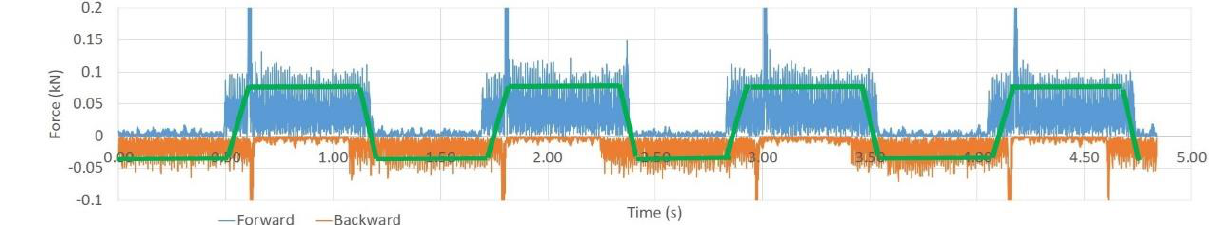
Figure 4. Recording forces when handling the saw (vertical — red colour, forward — cyan colour, and backward — yellow colour). Figure 5. Measured (blue and orange color) and processed forces (green